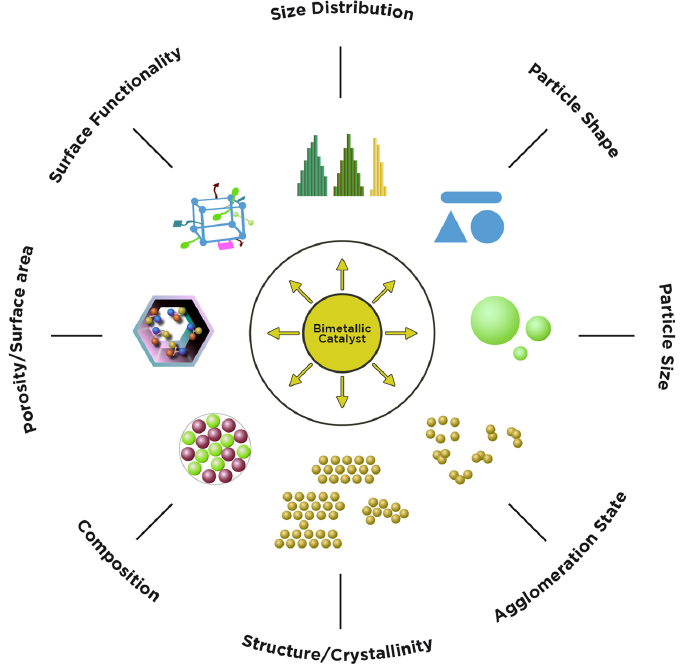
Figure 2. Factors affecting the catalytic properties of bimetallic catalysts in different reactions.